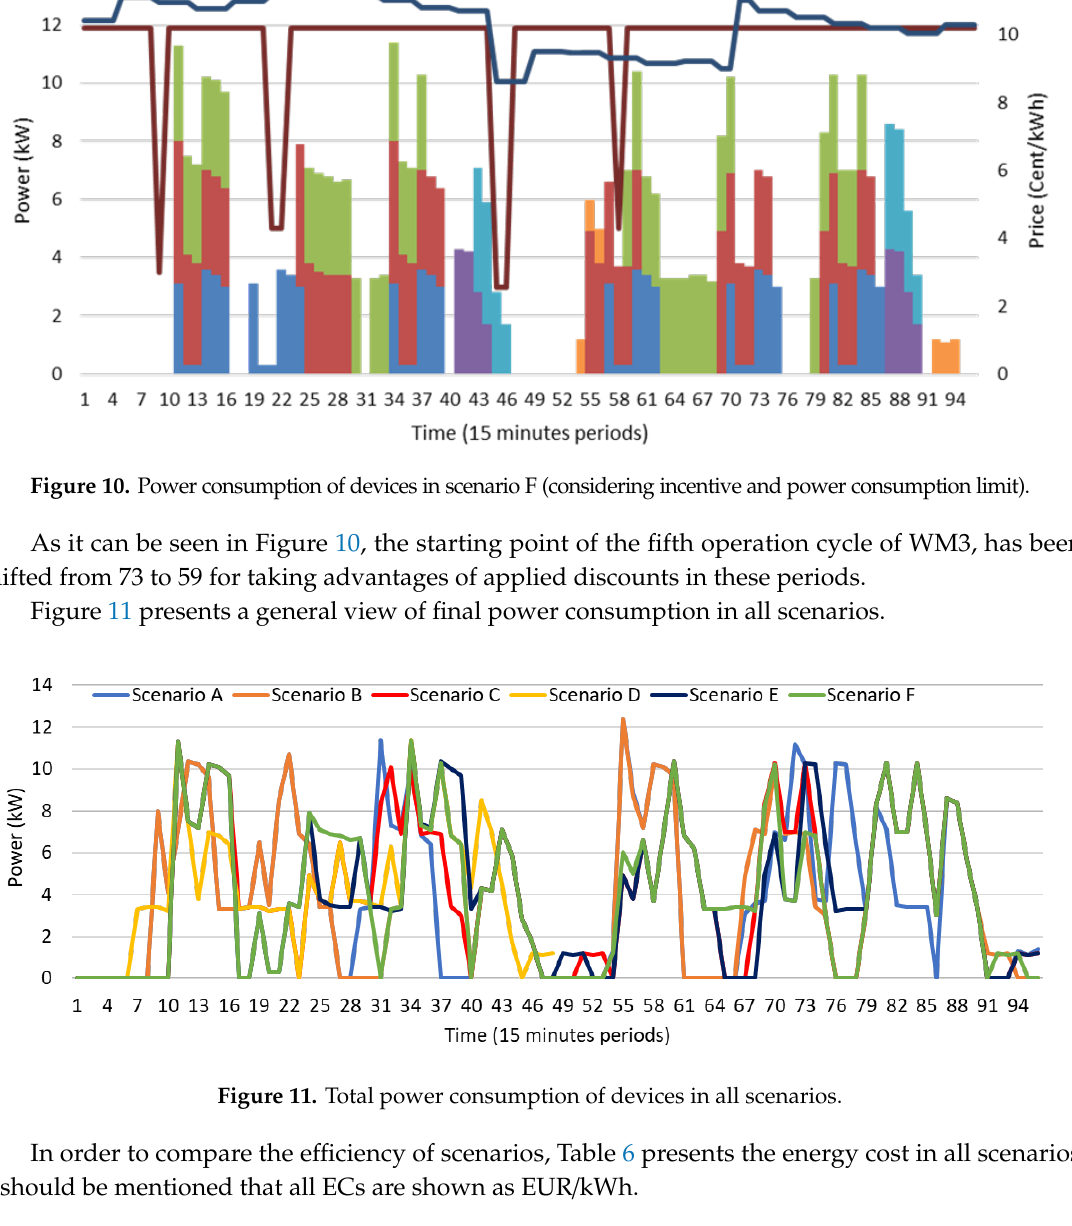
Table 6. Energy cost in all scenarios (SCN).